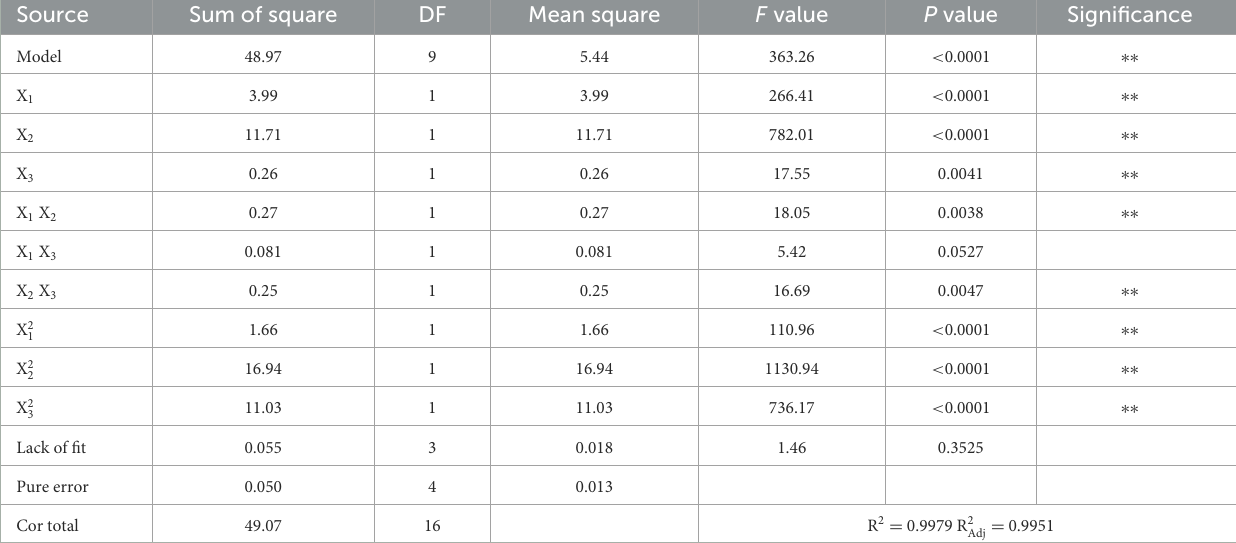
TABLE 3 Results of variance analysis of quadratic multinomial